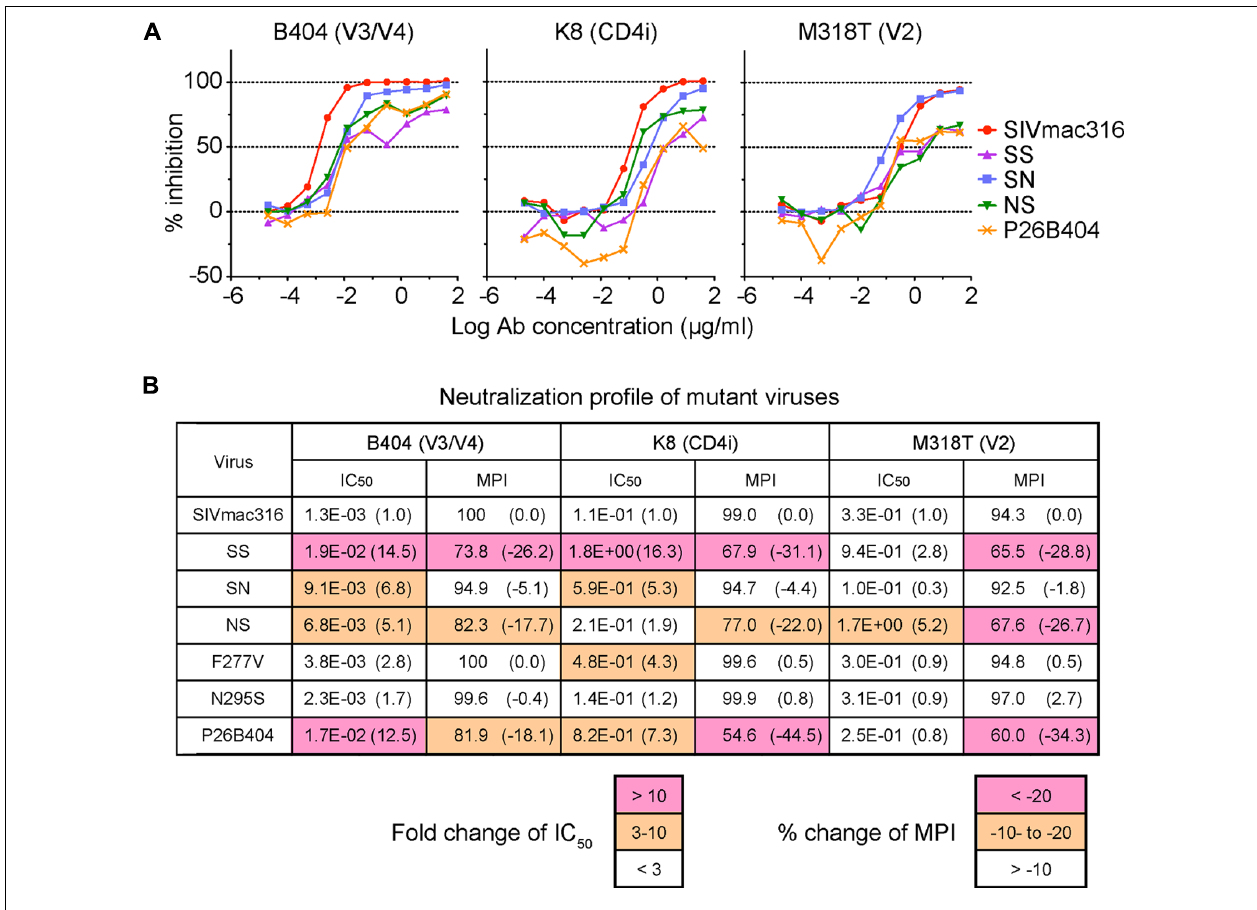
FIGURE 3 | Sensitivities of viruses with B404-resistant mutations to neutralization by MAbs. (A) Sensitivities of mutant viruses SS, SN, and NS to neutralization by MAbs Fab-B404 (anti-V3/V4), Fab-K8 (anti-CD4i), and M318T (anti-V2) are shown. Neutralization of parental SIVmac316 and B404-resistant P26B404 is also shown as controls sensitive and resistant to neutralization, respectively. (B) The sensitivities to neutralization are represented by values for IC 50 ( μ g/ml) and MPI (%).Viruses were examined